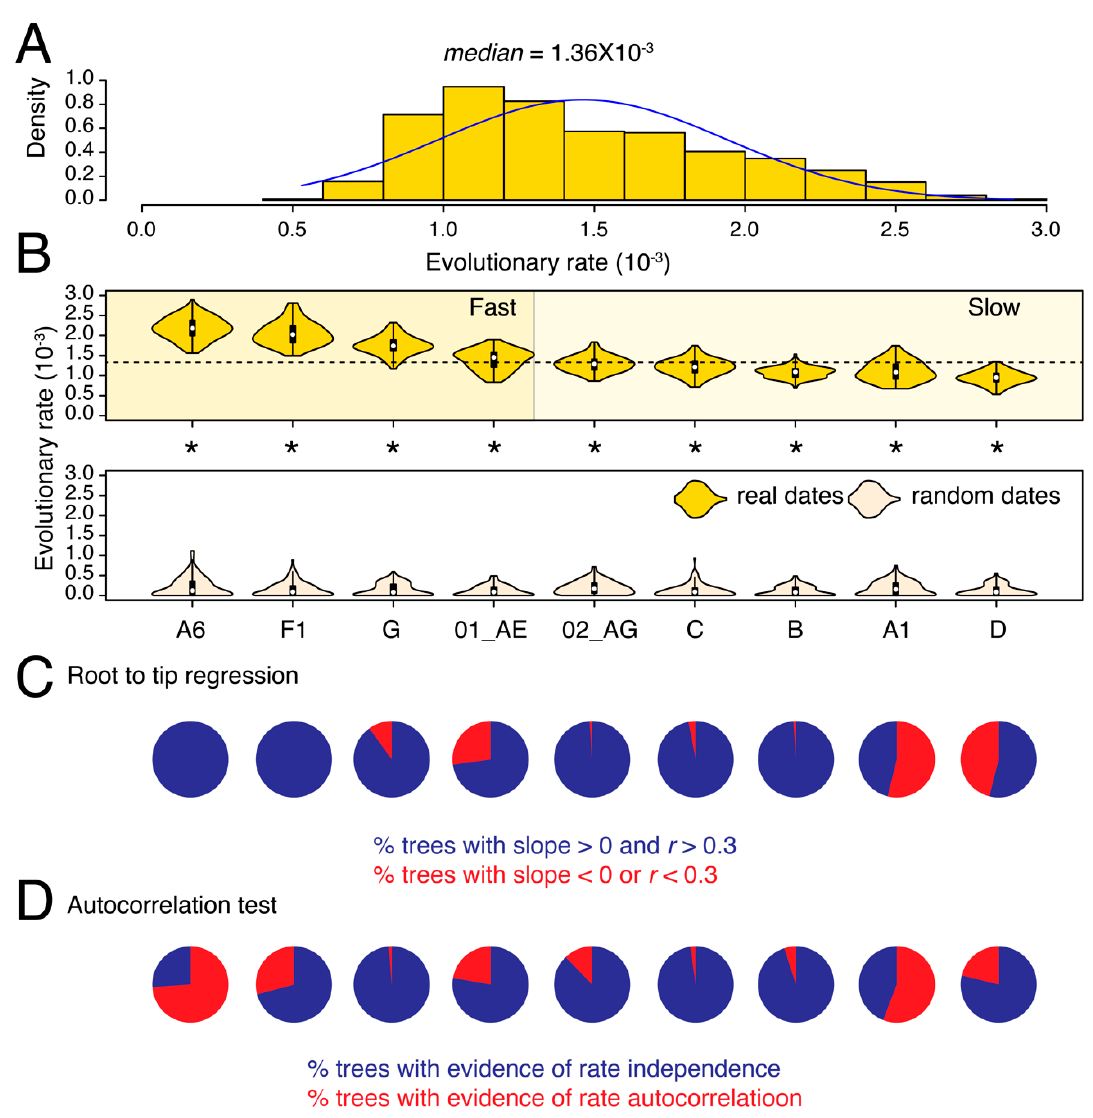
Figure 1. Substitution rate heterogeneity in pol . ( A ) The histogram displays the distribution of calculated substitution rates for all 900 pol tree reconstructions. Median of the distribution is listed on the top. ( B ) The violin plots show the distribution of substitution rates calculated individually for each subtype/CRF (i.e., across 100 tree reconstructions). The white circle indicates the group median. The dotted horizontal line represents the global median rate calculated in ( A ). Distributions of substitution rates calculated for trees with real and random dates can be compared. All comparisons were statistically significant (indicated by asterisk) . ( C ) Pie-charts show the proportion of phylogenetic trees that failed the RTT tests described in text. ( D ) Pie-charts show the proportion of phylogenetic trees with evidence of autocorrelated rates. Note that the latest version of the CorrTest program [26] only works with standard ML trees and not dated trees. The mean and median substitution rates, along with 95% CIs, for each subtype and CRF are also reported in Table 2. Note that Table 2 excludes trees where RTT slope was either negative or r was < 0.3.